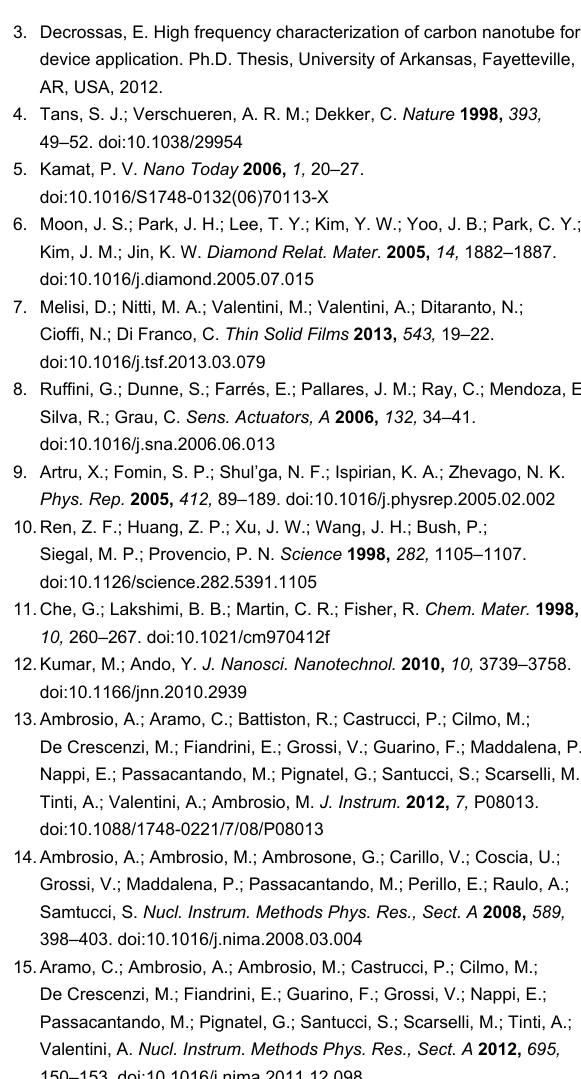
mental results obtained for the